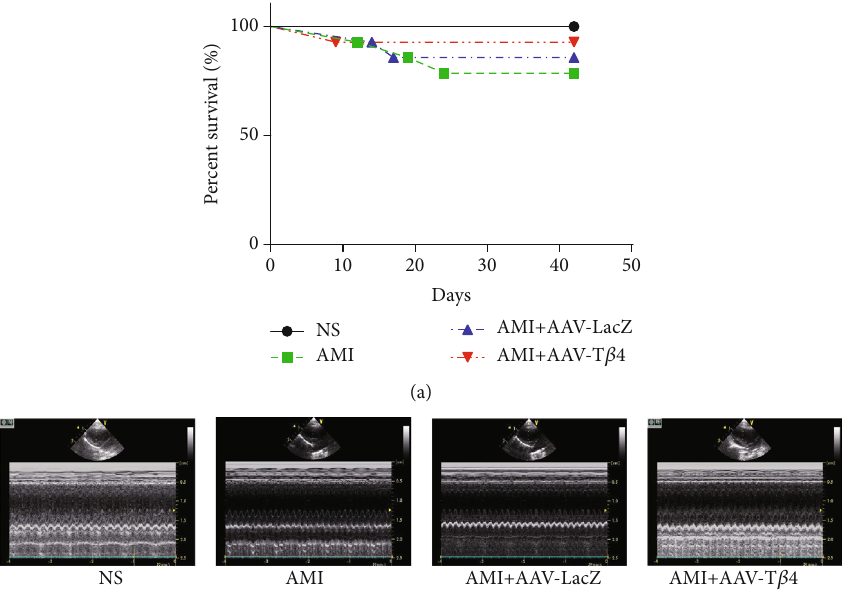
Figure 4: AAV-T β 4 alleviates ligation-induced heart infarction in mice survival curve of mice in the NS, AMI, AMI+ AAV-LacZ, and AMI +AAV-T β 4 groups (a). Representative M-mode echocardiogram was conducted on conscious animals in cardiac function on day 42 after ligation (b). Table 1: AAV-T β 4 improves cardiac function of AMI mice.